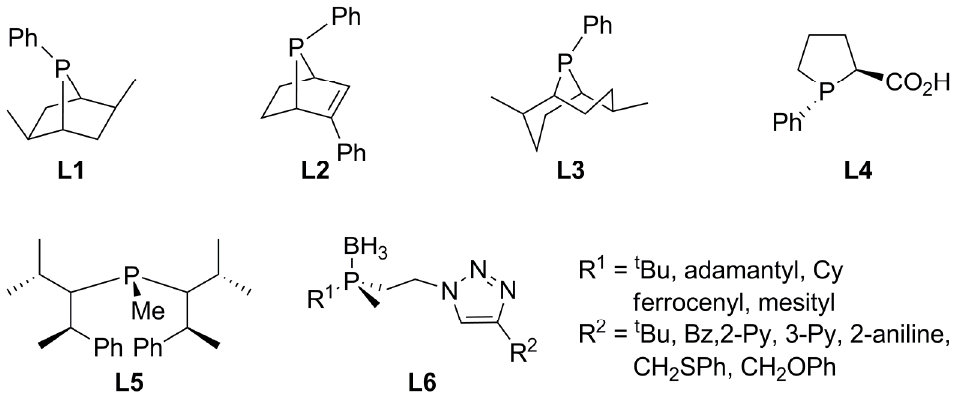
Figure 1. Monophosphine ligands with central